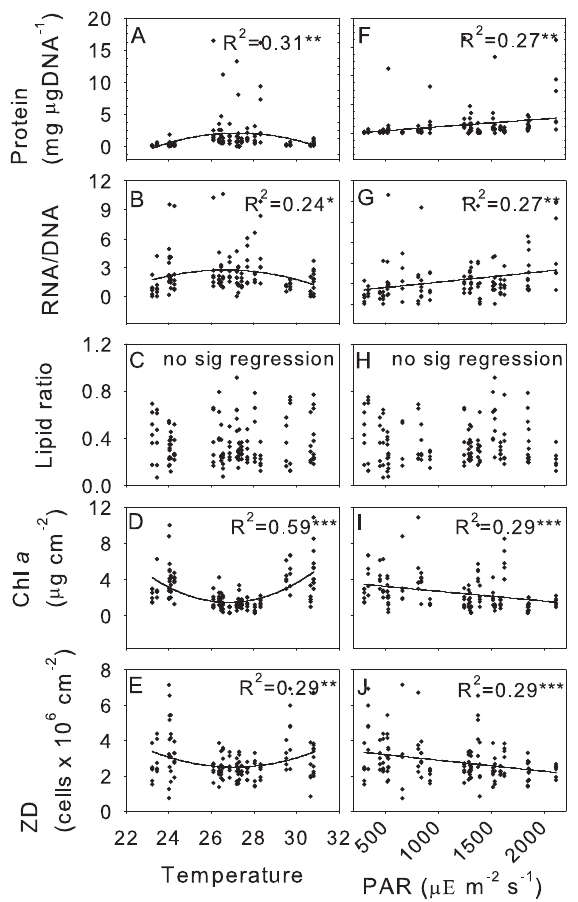
Figure 5. Correlation between health indices with temperature and light for Acropora spicifera. Quadratic correlations (R 2 ) of temperature (A–E) and linear correlations (R 2 ) of PAR (F–J) with Protein concentration, RNA/DNA ratio, lipid ratio, chl a concentration and zooxanthellae density.